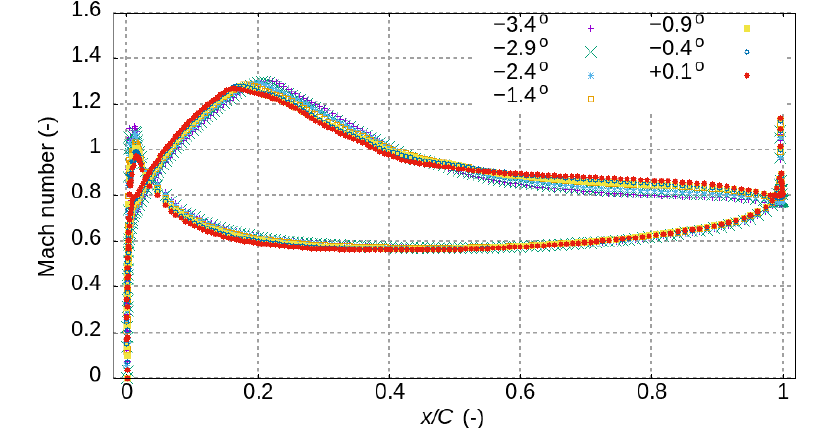
Figure 10. Midspan time-averaged isentropic Mach number profiles for varying β at buffeting operating